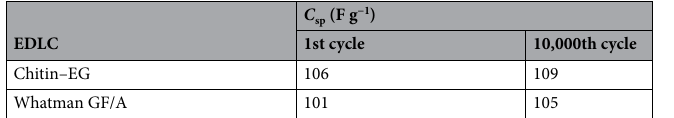
Table 2. Specific capacitance ( C sp ) of EDLC cells, calculated from the GCD test after 1st and 10,000th cycle.